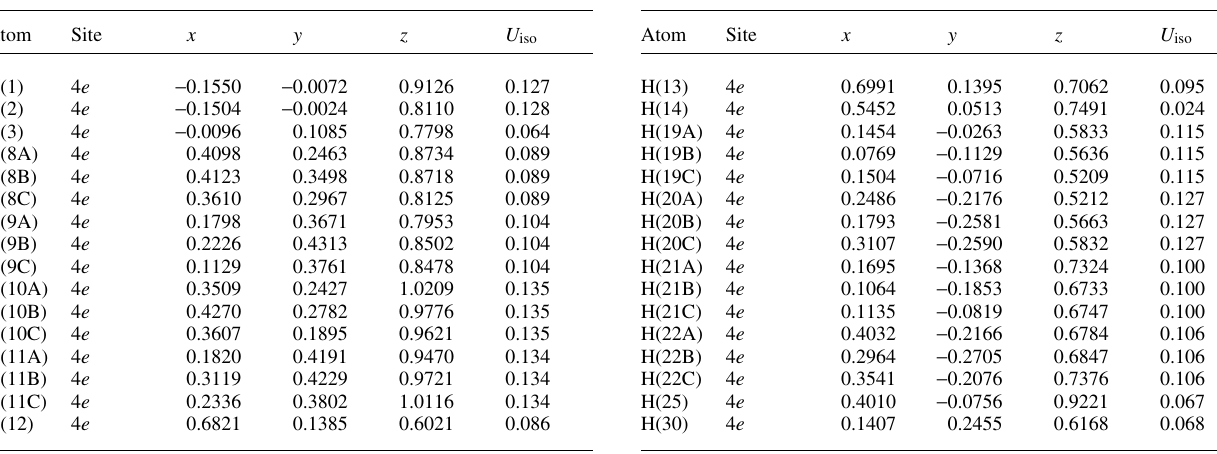
Table 2. Atomic coordinates and displacement parameters (in Å 2 )